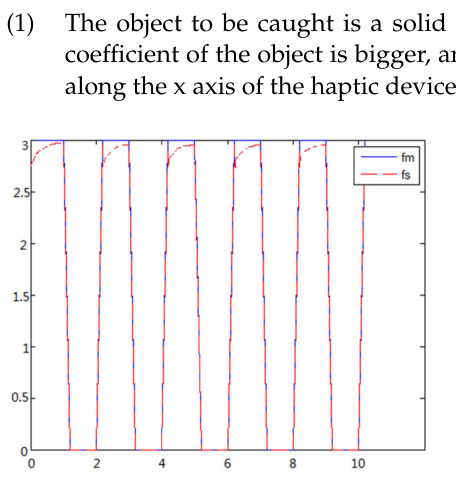
Figure 15. Force feedback along x axis. (No time